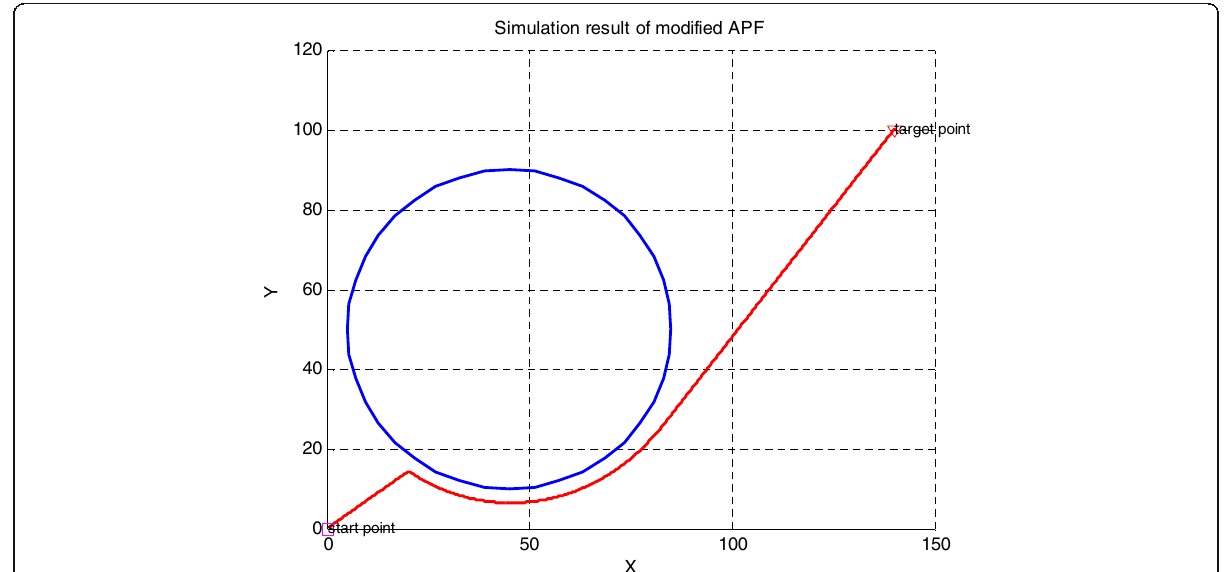
Fig. 14 The simulation result of the modified artificial potential field algorithm for circular obstacles with radius R =